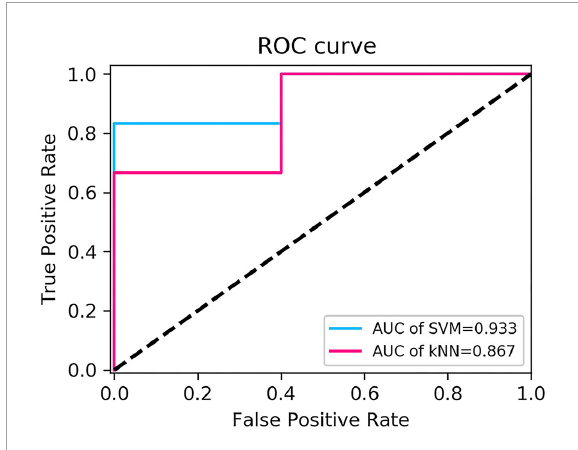
FIGURE6 Comparison of receiver operating characteristic curves of the two